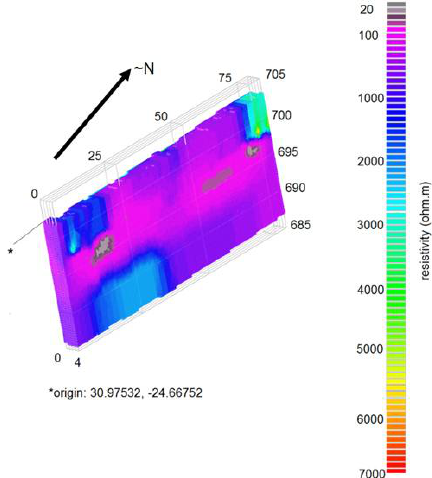
Fig. 10. Pseudo 3-D resistivity section of the SE-NW parallel tran- sects. Scales are in metres diverging from a geographical origin, vertical scale is altitude a.s.l. (Wenner long, 2m spacing, 8th itera- tion, RMS error